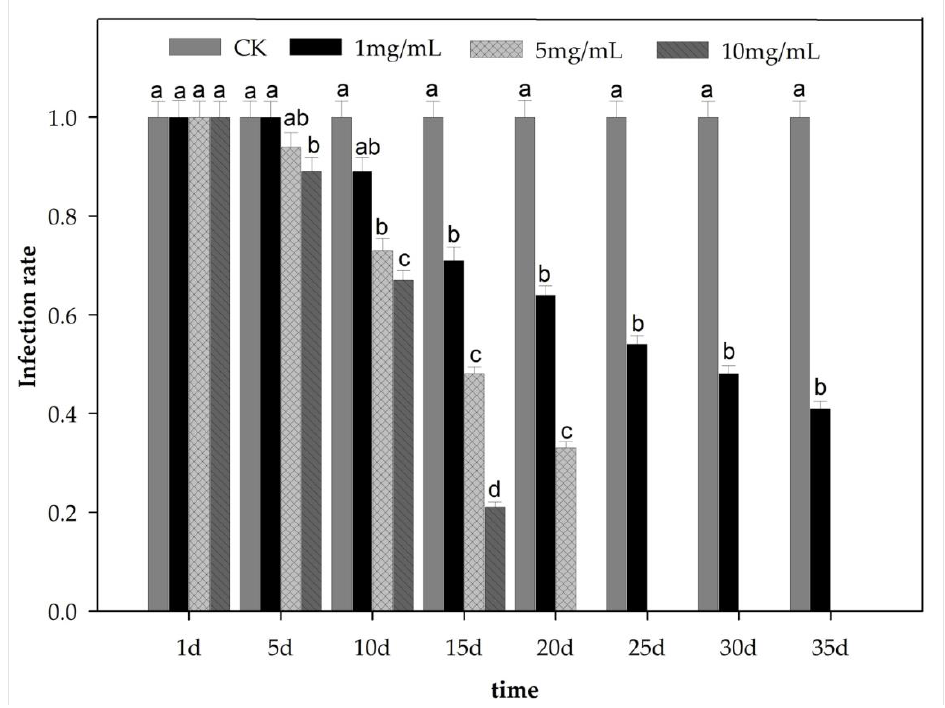
Figure 5. Biotics treatment and Wolbachia infection rate. Different letters indicate significant differ- ences at p ≤ 0.05.